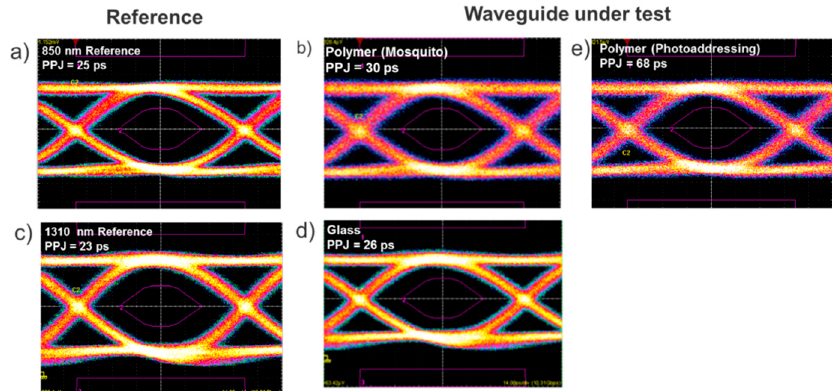
Figure 16. Eye diagrams for 10.3 Gb/s with the PRBS 2 31 -1 test signal conveyed over selected polymer and glass waveguides, ( a ) 850 nm reference eye diagram with direct fiber coupled to a communications signal analyzer (CSA), ( b ) Mosquito waveguide channel 5 at 850 nm, ( c ) 1310 nm reference eye diagram with direct fiber coupled to a CSA, ( d ) IZM glass waveguide set 7 channel 12 at 1310 nm; ( e ) Photo-addressed waveguide channel 7 at 850 nm.